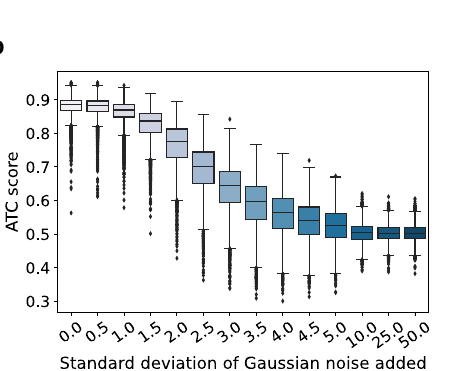
neighbors were considered to build the nearest neighbor graphs. b A test in clus- tering similarity on 6800 pairs of trajectories. The number of nearest neighbors usedis fi ve. c Atestinclusteringresolutionon40,800pairsoftrajectories.Thebox plots show the median with bounds for the fi rst and the third quartiles, and the whiskers indicate the minimum and the maximum that exclude outliers repre- sented by points. Source data are provided in the Source Data fi le.